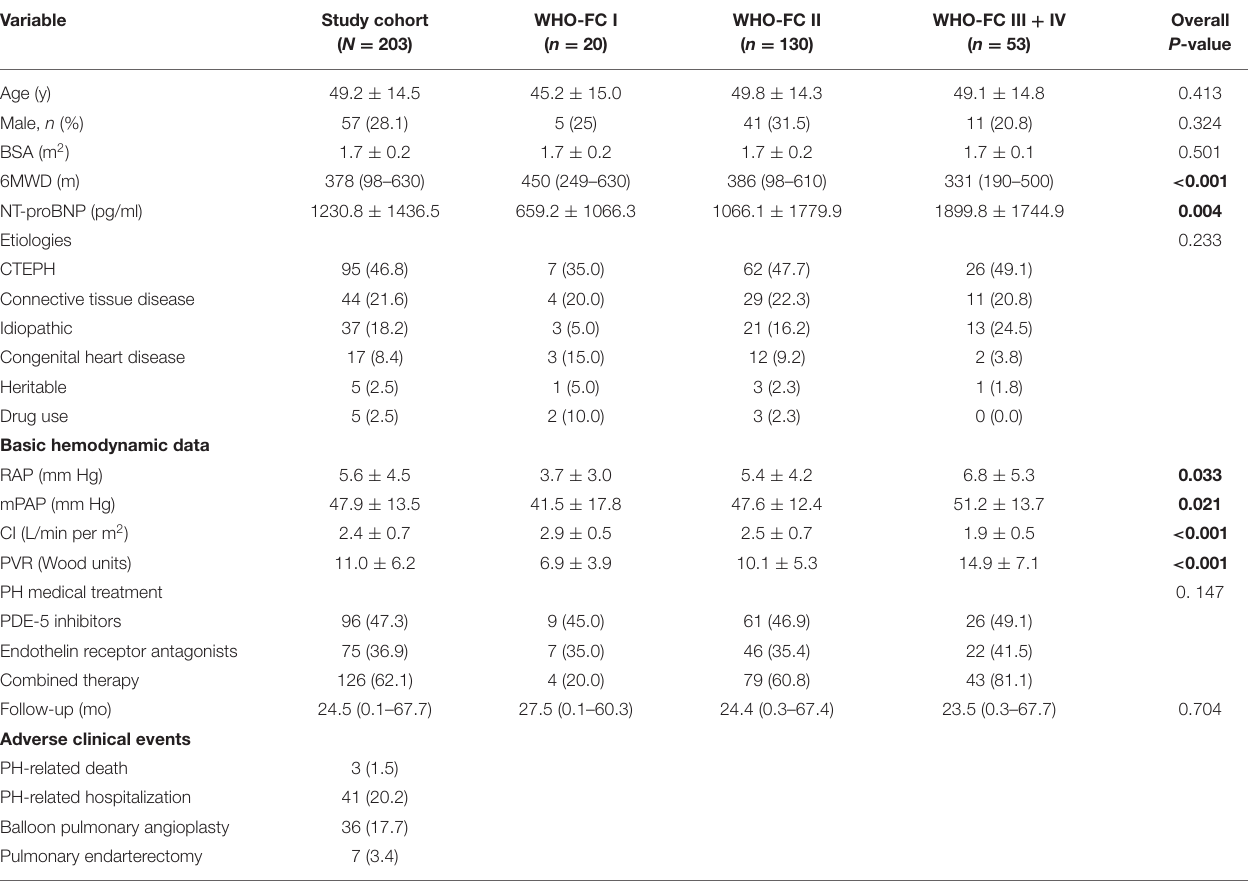
TABLE 1 | Demographic and baseline clinical characteristics of patients with precapillary PH.